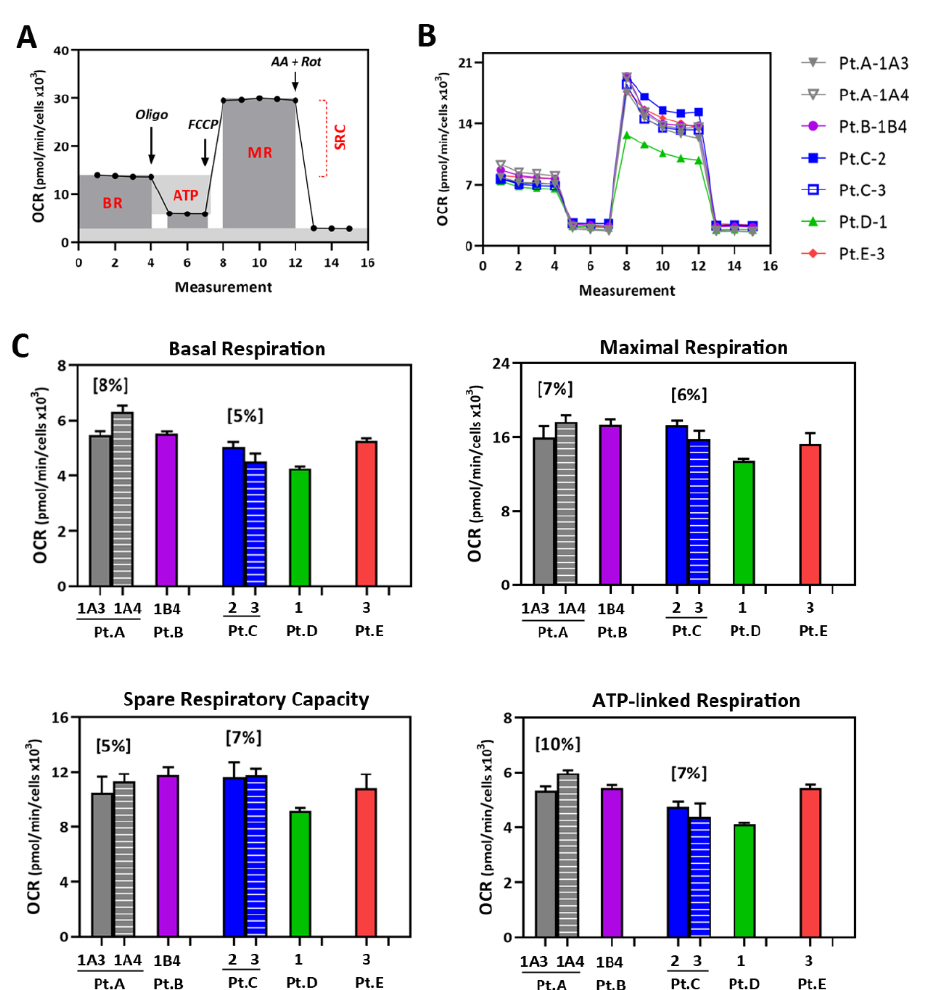
Figure 3. Testing mitochondrial function in iPSC-RPE from patients with AMD. ( A ) Example trace associated with Cell Mito Stress Test (CMST). Analysis of oxygen consumption rate (OCR) following injections of oligomycin (oligo), FCCP, and antimycin A + rotenone (AA + Rot) to perturb mitochondrial function. Calculation of the basal respiration (BR), maximal respiration (MR), spare respiratory capacity (SRC), and ATP-linked respiration (ATP) is shown. ( B ) Traces from CMST of OCR for patient-specific iPSC-RPE (five patients, seven lines). ( C ) Parameters of mitochondrial function were calculated from data shown in ( B ). Mean ± SEM. Numbers in brackets indicate coefficient of variation (CV) of OCR for two cell lines from the same patient.